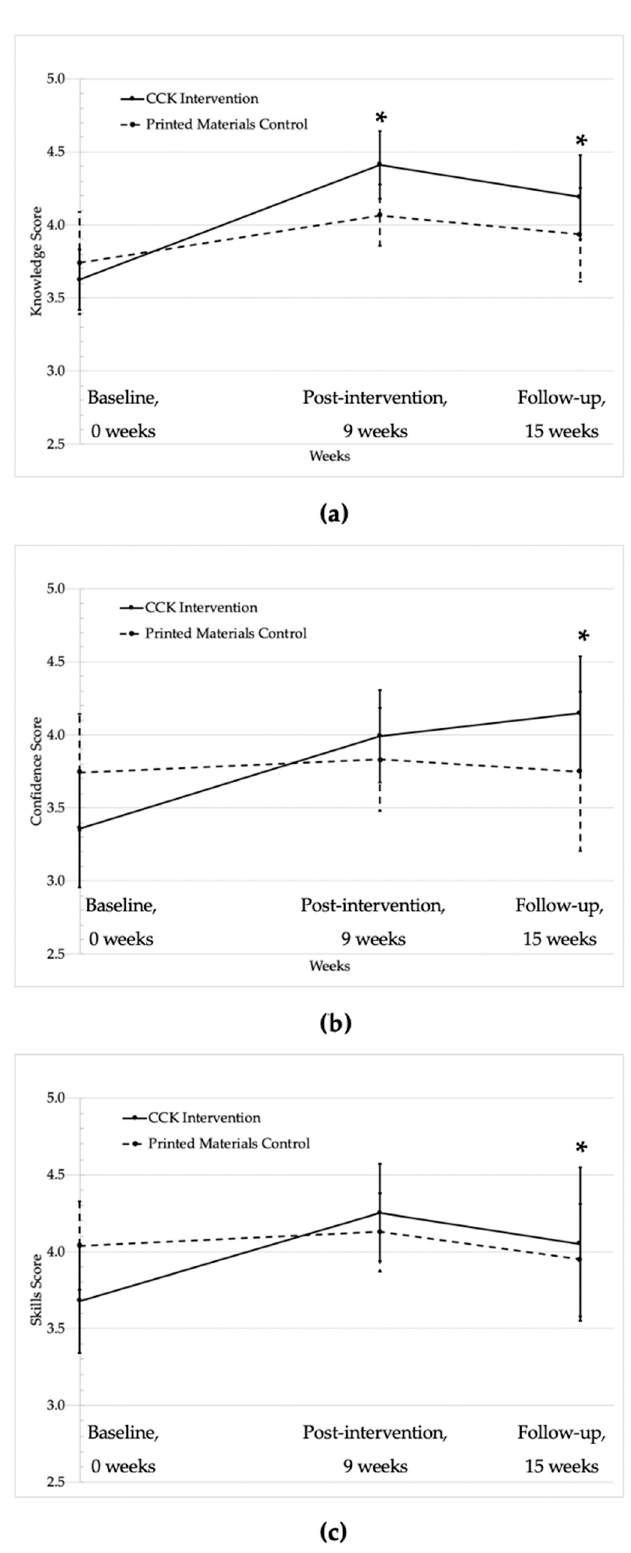
Figure 2. Change in ( a ) knowledge about a plant-based diet, ( b ) confidence preparing a variety of plant foods in a tasty way, and ( c ) skills to practice a plant-based diet for the Coping with Cancer in the Kitchen intervention group and the printed materials control group. * p < 0.05, difference between intervention and control groups adjusting for baseline level and study site. CCK: Coping with Cancer in the Kitchen